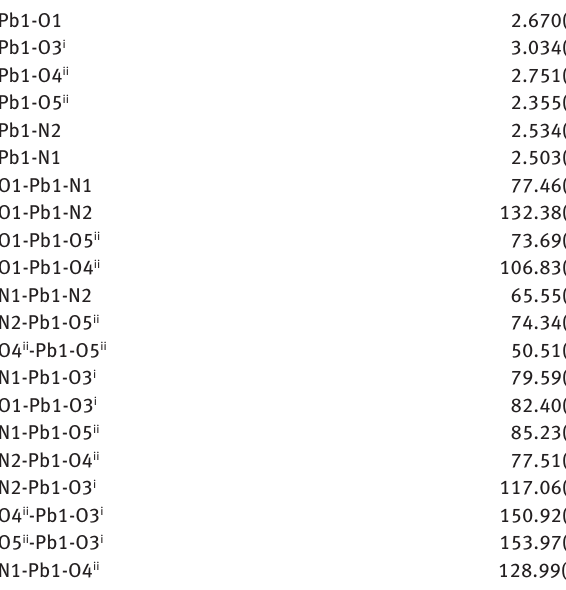
Table 1 Selected bond lengths ( Å ) and angles (deg) for the title compound.